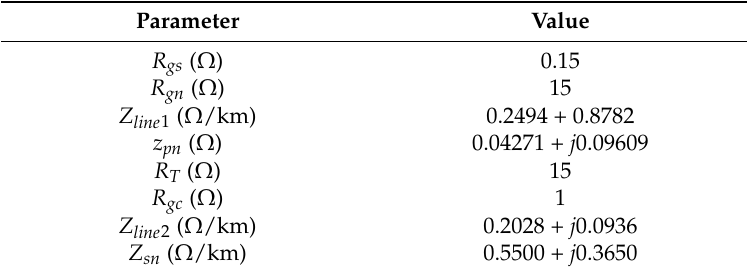
Table 3. System parameters of the Monte Carlo simulation.